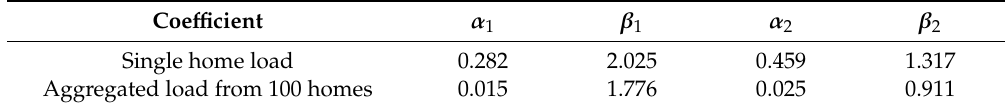
Table 1. Coe ffi cients of the price prediction model [40].